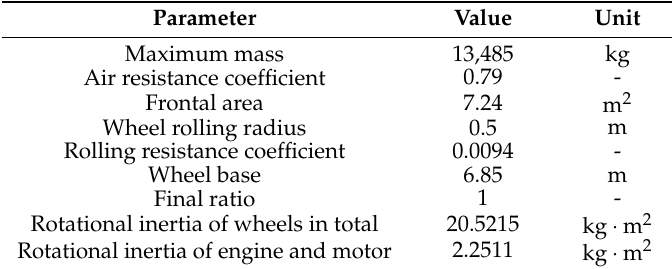
Table 6. Parameters of the PHEV.